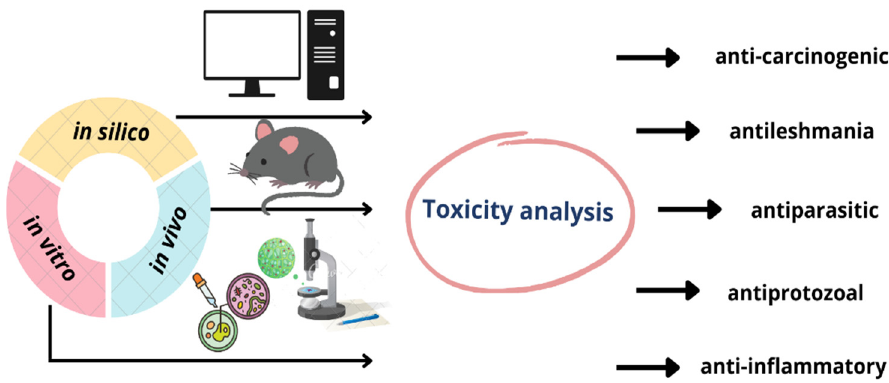
Figure 2. Biological activities that can result from in vivo, in vitro, and in silico toxicological stud- ies.